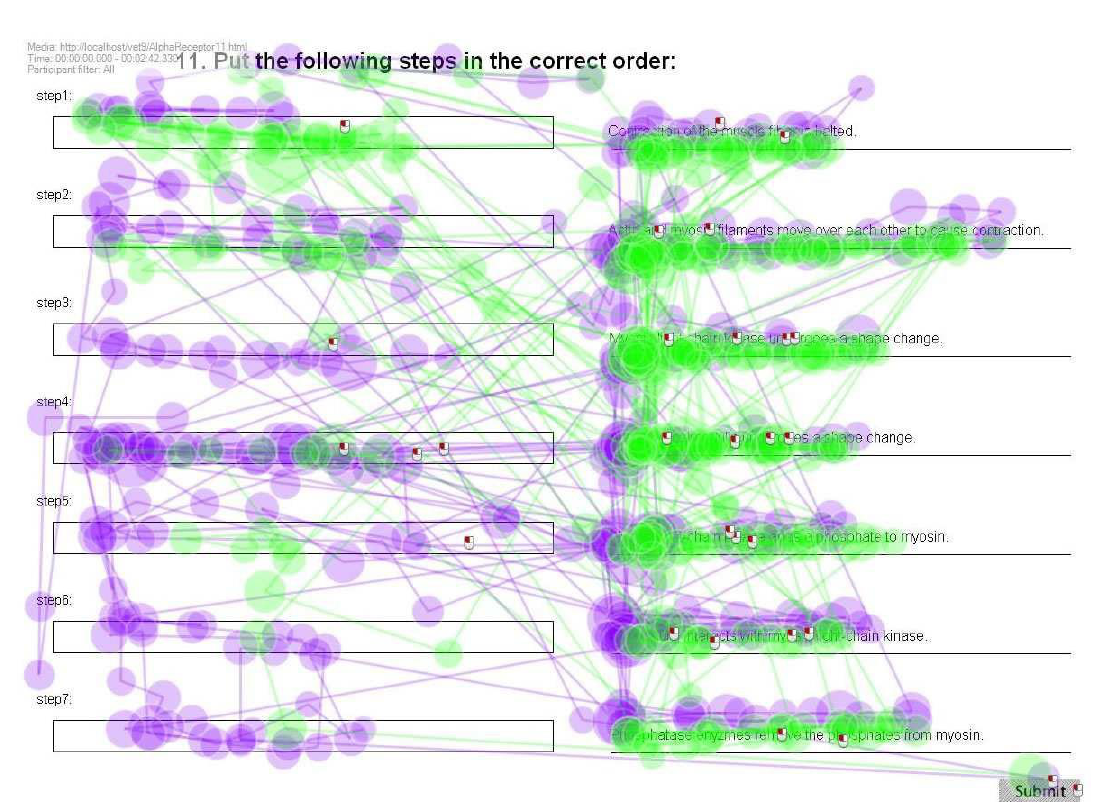
Figure 4. Gaze plots of the third ordering problem from a student who solved the problem correctly (green) and student who solved incorrectly